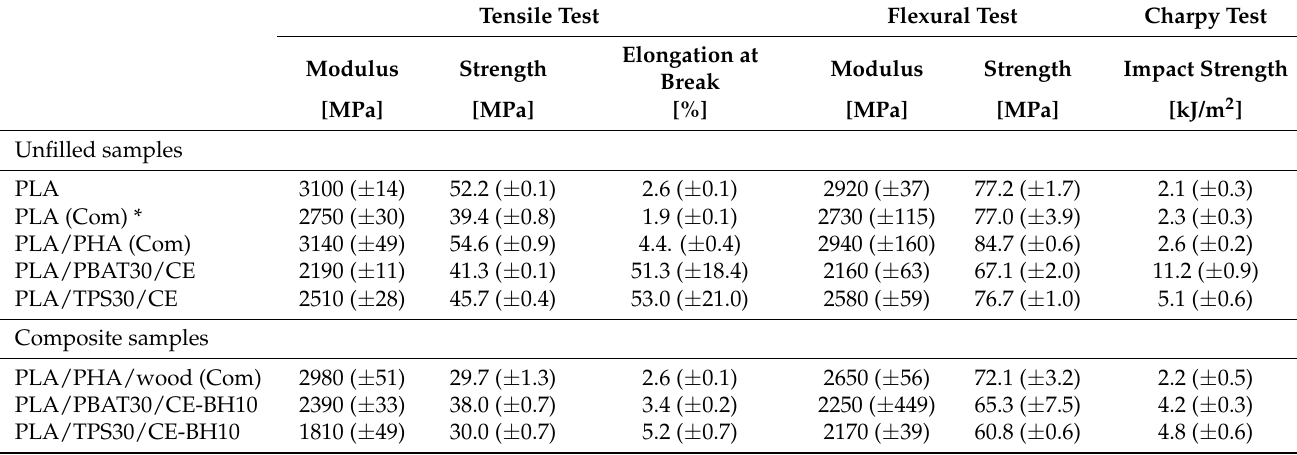
Table 3. The comparison of the mechanical performance for developed materials and commercially available filaments. Tensile Test Flexural Test Charpy Test Elongation at Modulus Strength Modulus Break